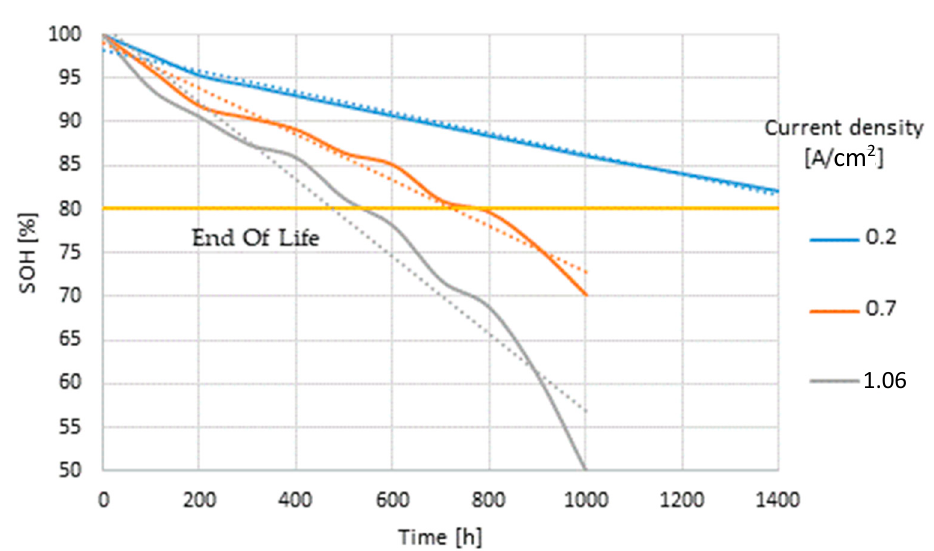
Figure 7. Power rate—FC aging behavior.